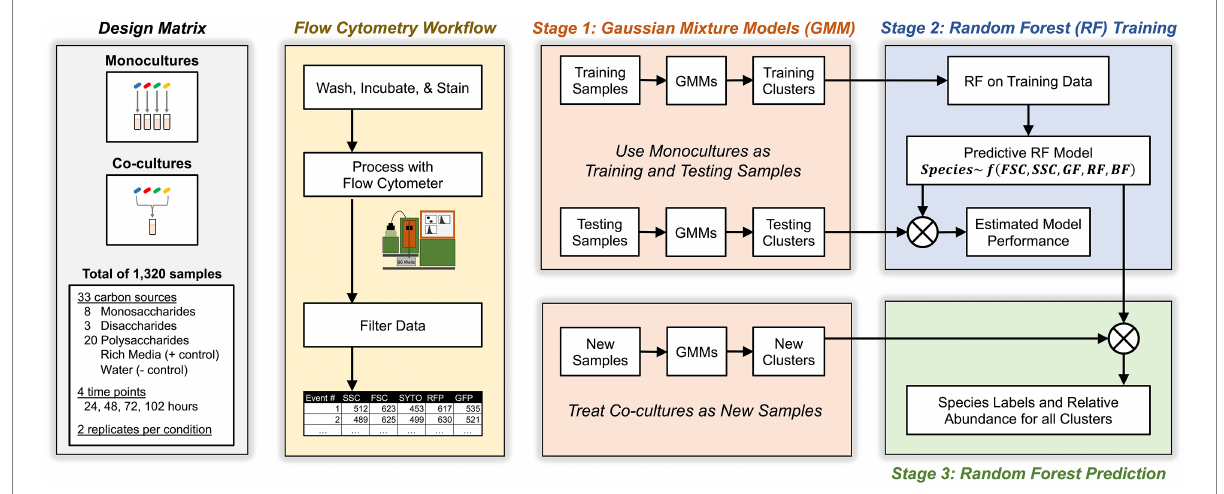
FIGURE 2 Schematic for experimental, flow cytometric, and machine learning workflows. Study design included monocultures and co-cultures of four Bacteroides species on minimal media supplemented with one of 31 carbon substates. At different time points, cultures were sampled, washed, stained, then analyzed with flow cytometry. Flow events were filtered based on pre-determined criteria then analyzed with a three-stage machine learning algorithm that maps flow cytometry clusters in co-cultures to individual Bacteroides